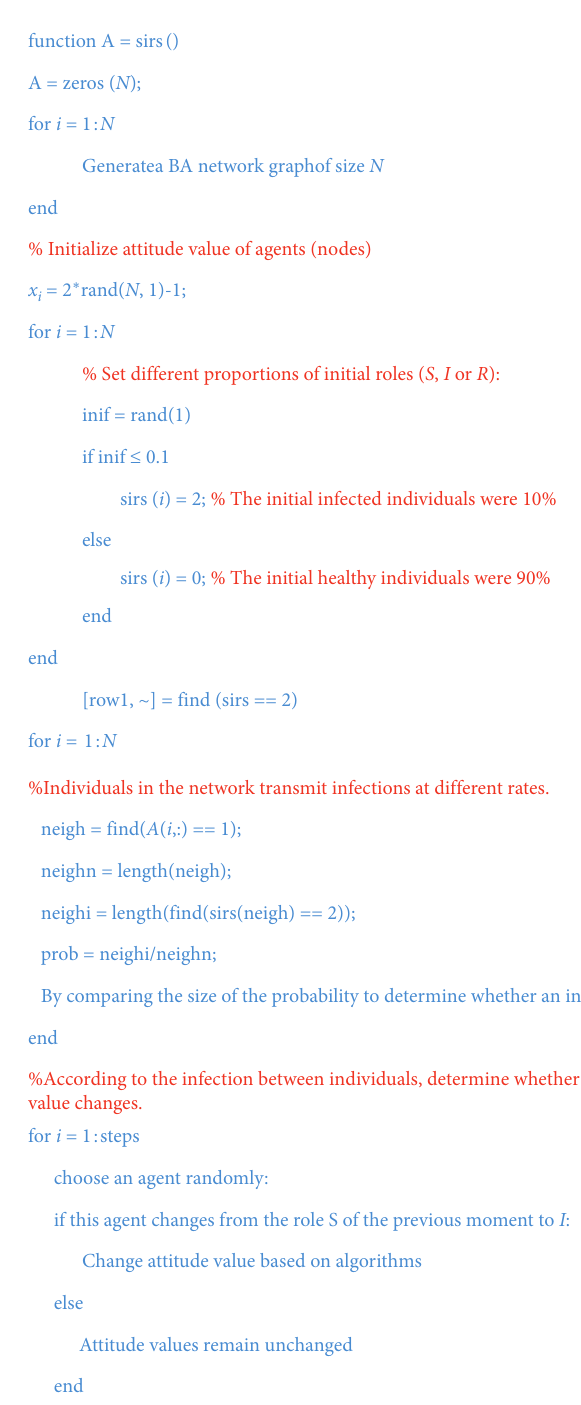
Figure 4: Pseudocode of the SIRS